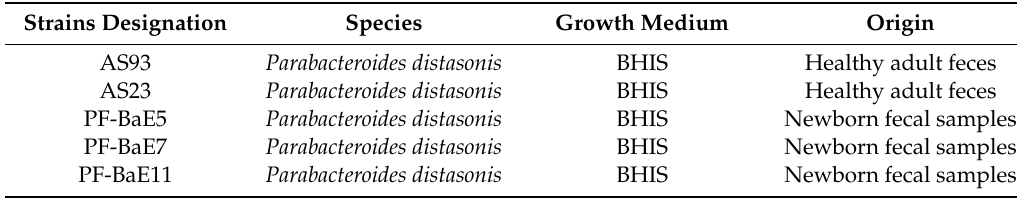
Table 1. Bacterial strains, growth media and